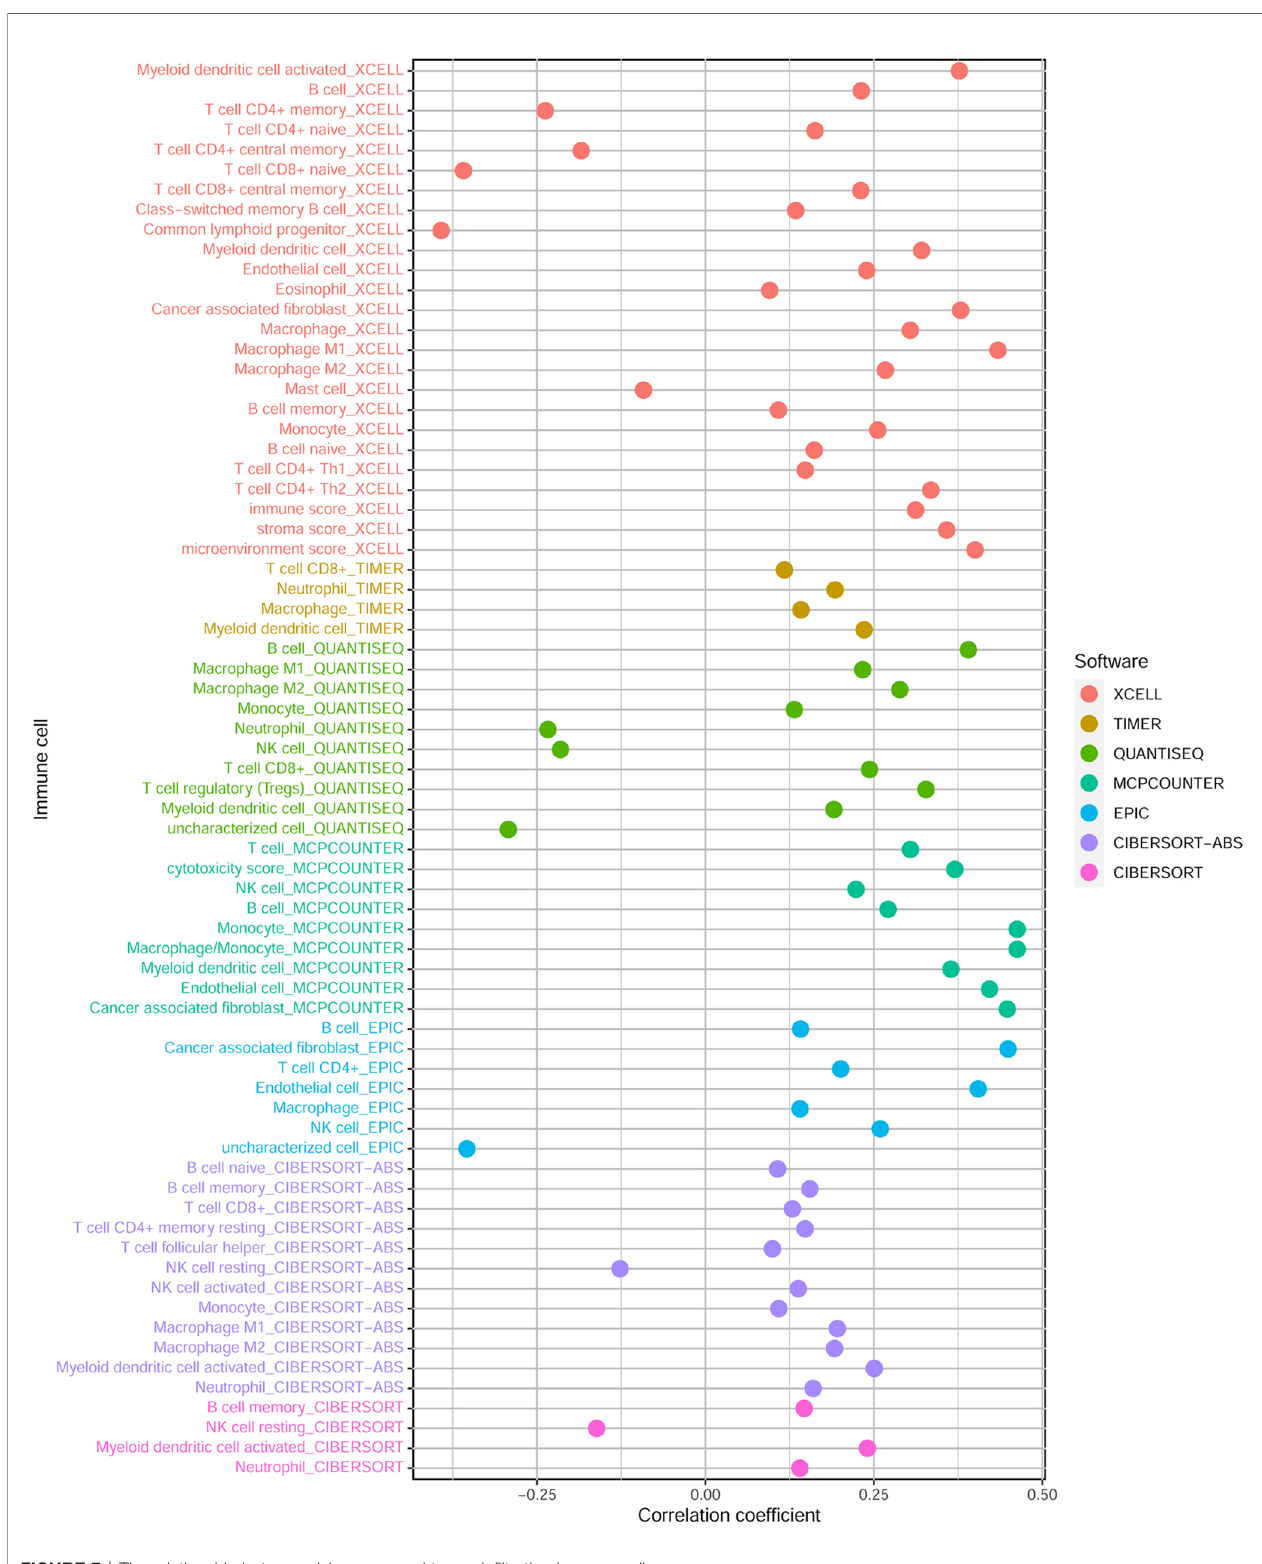
FIGURE 7 | The relationship between risk scores and tumor-in fi ltrating immune